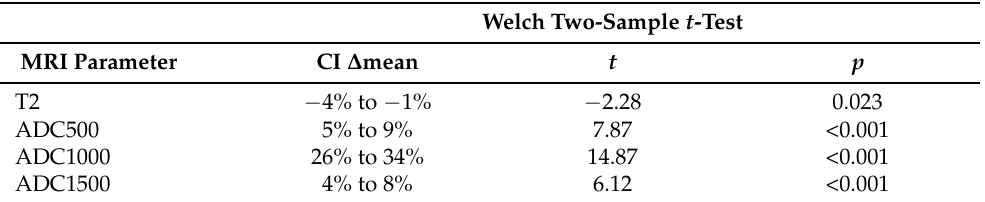
Table 2. Statistical analysis results for the Welch t -test on the pixel-level intensity variations between the malignant and benign groups.